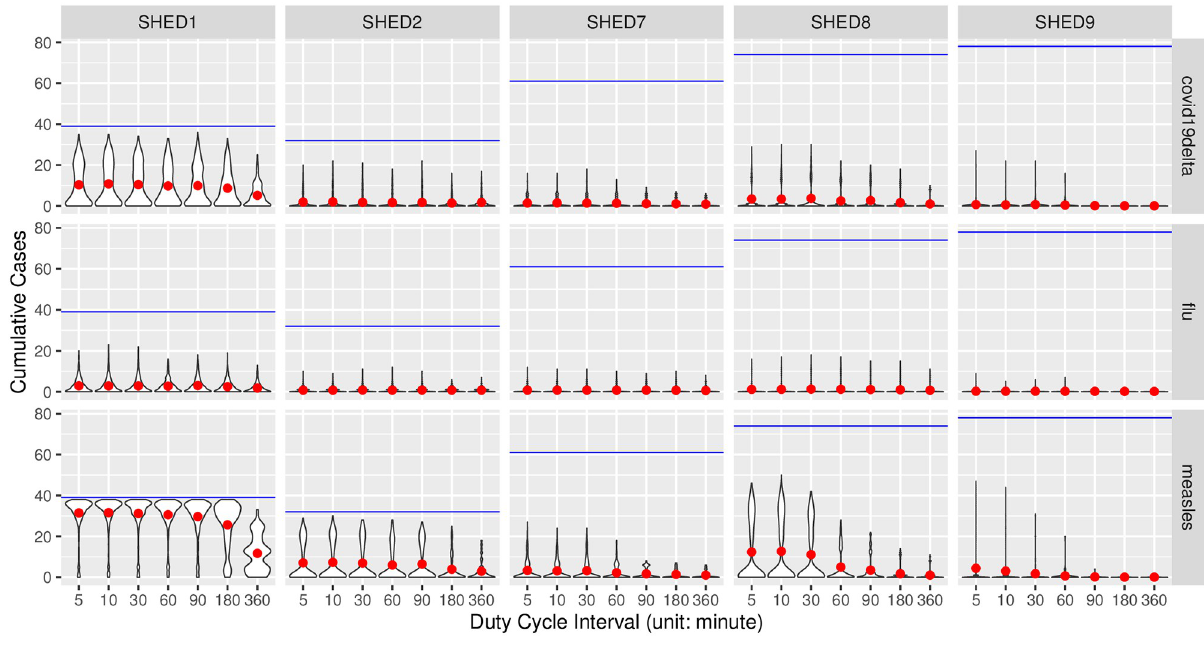
Fig 1. Grids of violin plots of cumulative cases for the Snapshot